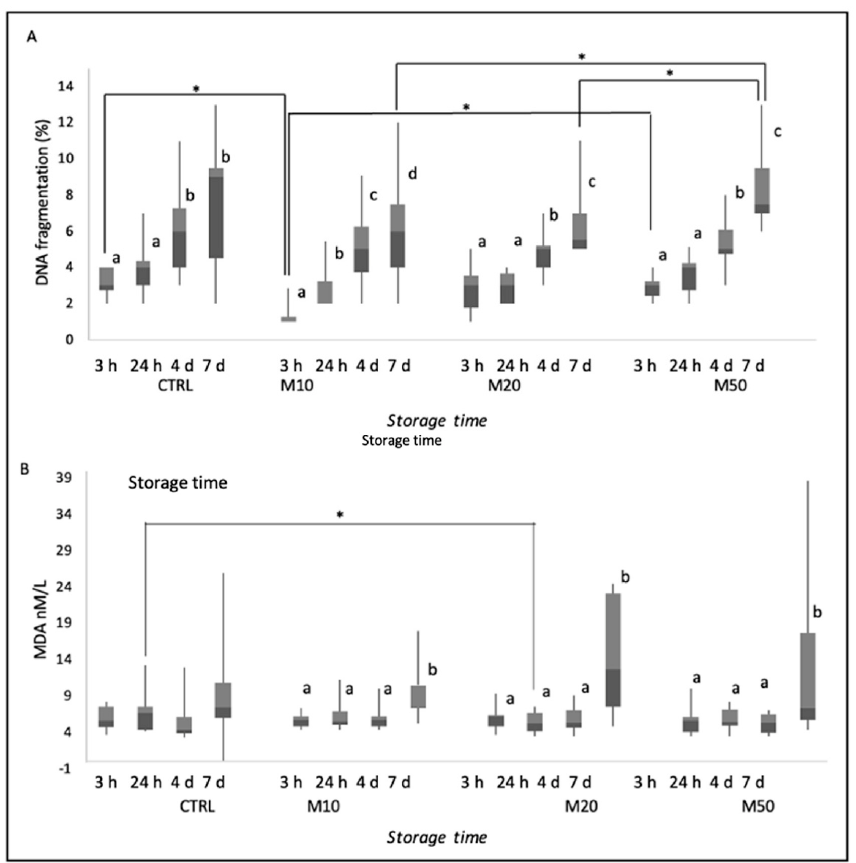
Figure 2. Percentage of DNA fragmentation ( A ) and lipid peroxidation ( B ) of dog semen ( n = 9) diluted with only egg − yolk tris − citrate glucose (EYT − G; CTRL) or with EYT − G with the addition of three different concentrations (10, 20 and 50 µ L/mL) of aqueous extract of Maca (M10, M20 and M50) stored at refrigeration temperature (4 ◦ C) and evaluated at 3 h, 24 h, 4 d and 7 d of storage. Asterisk above the bar indicates statistical difference between groups at p ≤ 0.05. The letters a, b, c and d indicate statistically significant differences at p ≤ 0.05 between time points within each